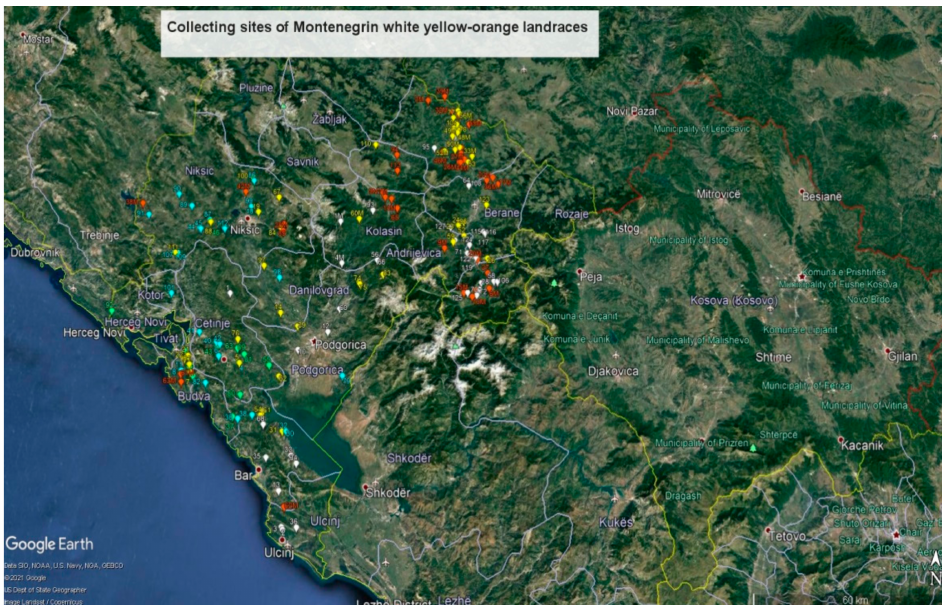
Figure 6. Map of collecting sites for yellow-orange maize landraces (Maize Research Institute Zemun Polje Gene Bank accessions—designated by number; Montenegrin plant gene bank accessions— designated by number and the letter M; Custer I—white, Cluster II—blue, Cluster III—yellow, Cluster IV—red, Cluster